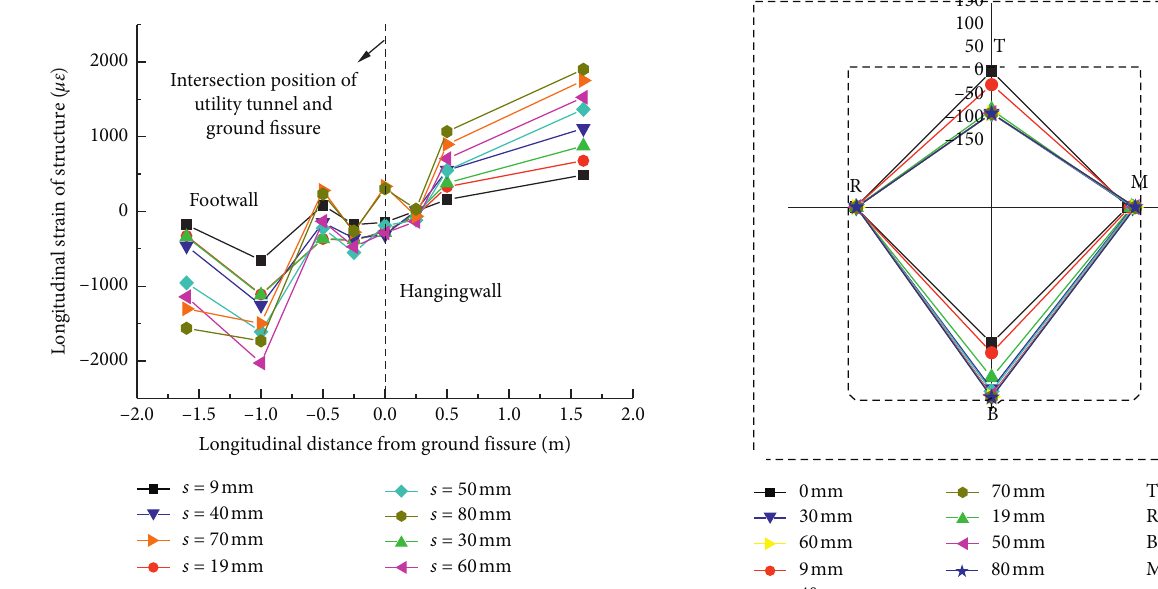
Figure 16: Longitudinal strain of top structure.